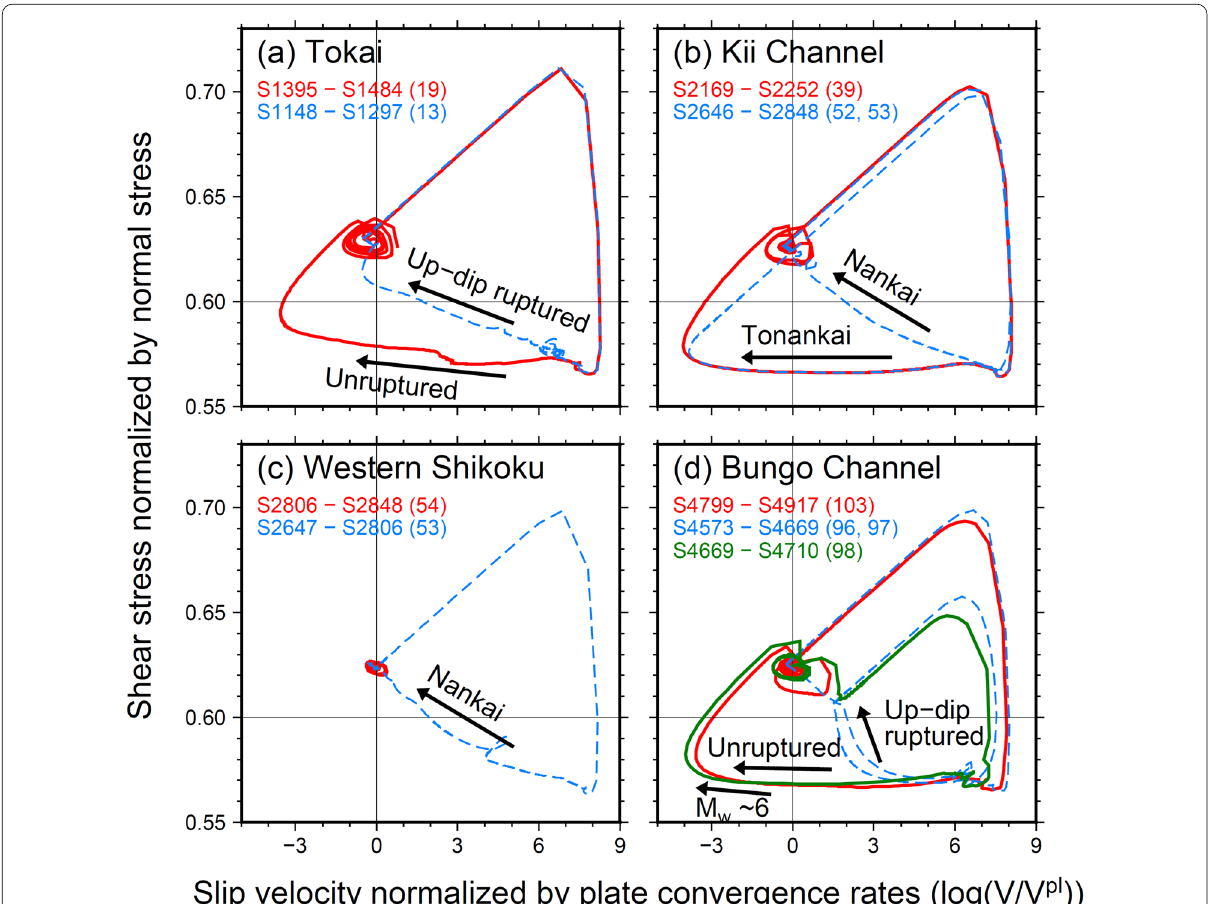
Fig. 14 Trajectory diagrams showing the relation between slip velocity and shear stress in the a Tokai, b Kii Channel, c western Shikoku, and d Bungo Channel segments (points 8–11 in Fig. 4e, f). Each line corresponds to the simulation period shown at upper left and includes the number of the event during that period, shown in Additional file 1: Fig.